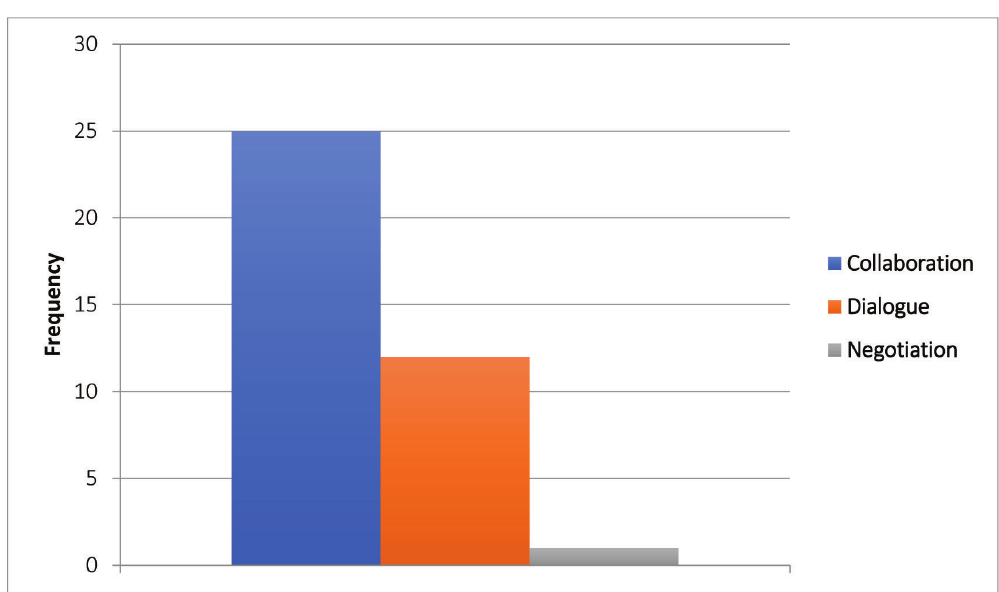
Figure 3: Element Two – Nonviolent conflict transformation tools in Plan de Estudios